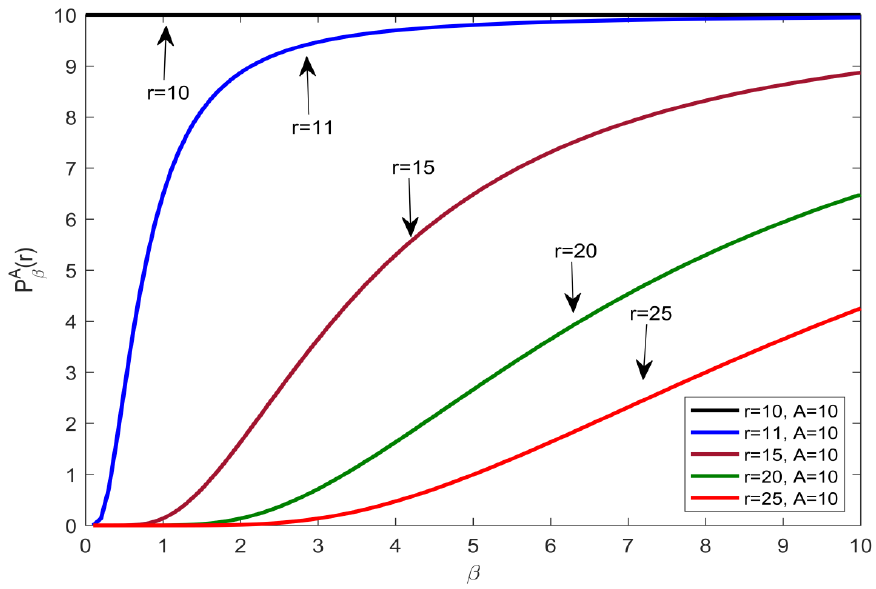
Figure 8. Palm Clipping function P A β ( r ) as a function of β with A = 10.